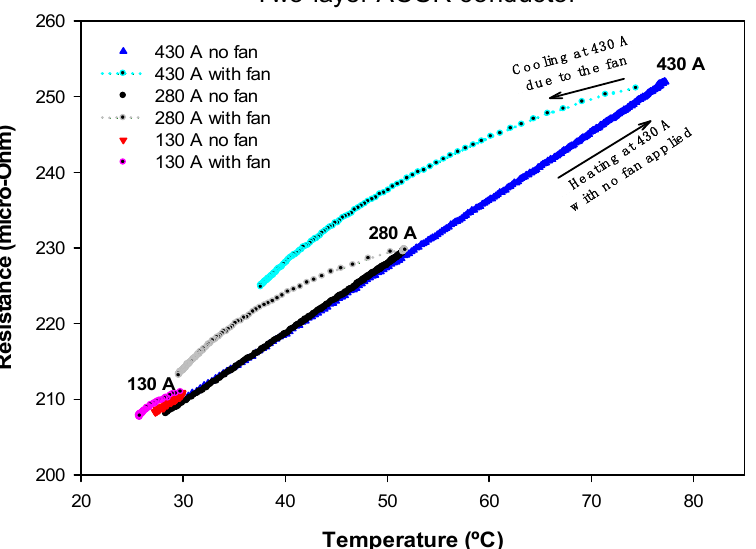
Figure 5. Two-layer ACSR conductor. R ac versus temperature measured for heating-cooling cycles at 430 A, 280 A and 130 A.